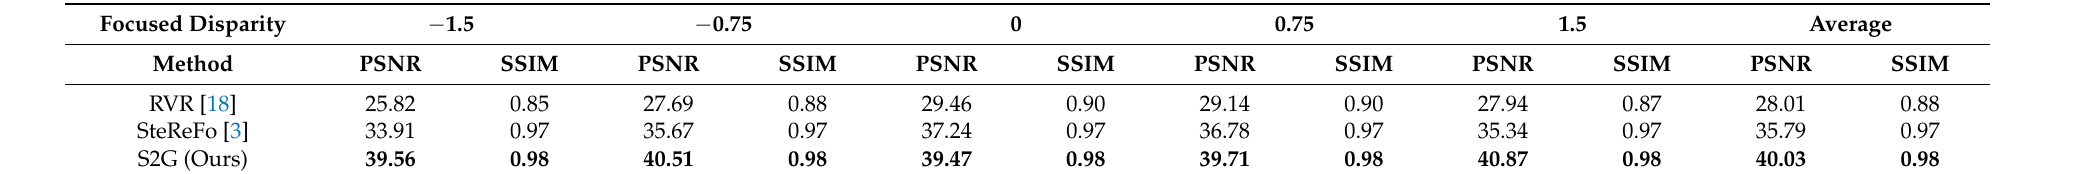
Table 5. Quantitative results of different DoF rendering methods on the 4DLF dataset [70]. The best performance is